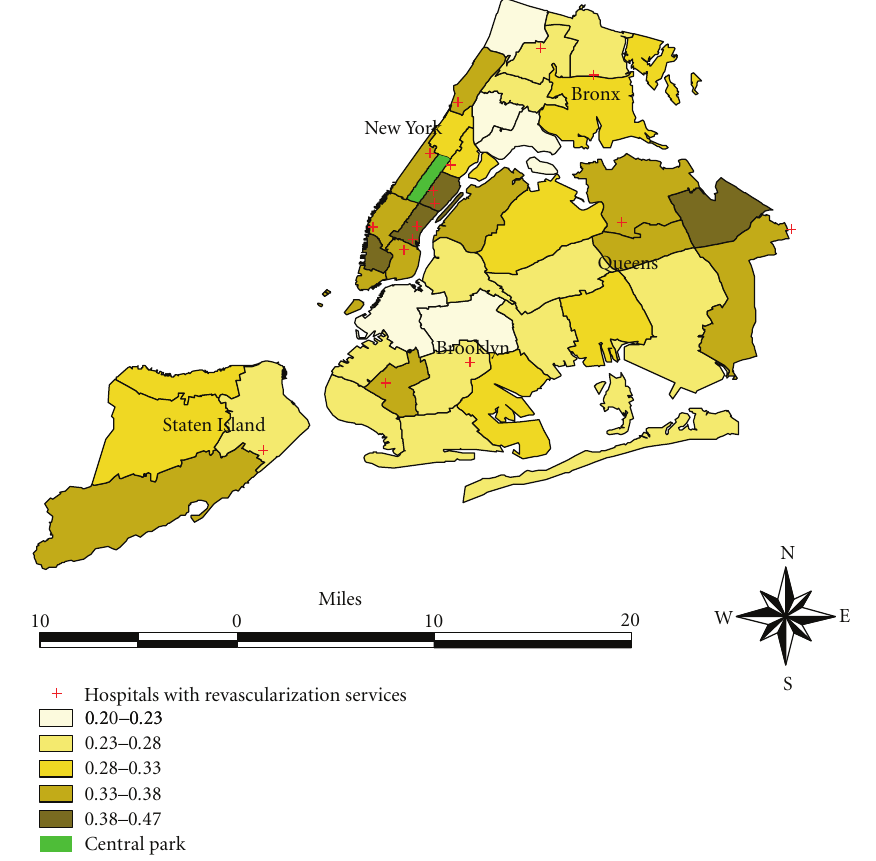
Figure 1: Crude rate of revascularization after AMI in NYC